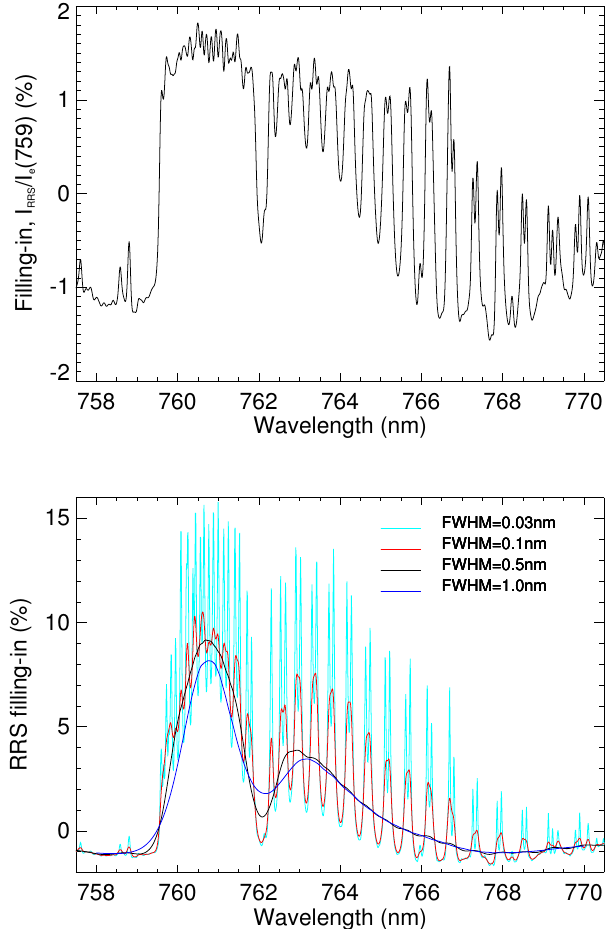
Fig. 9. Top: RRS filling-in computed for conditions similar to Sioris and Evans (2000) with their definition of filling-in (see text); Bottom: Filling-in computed for the same conditions with our definition and different spectral resolutions.